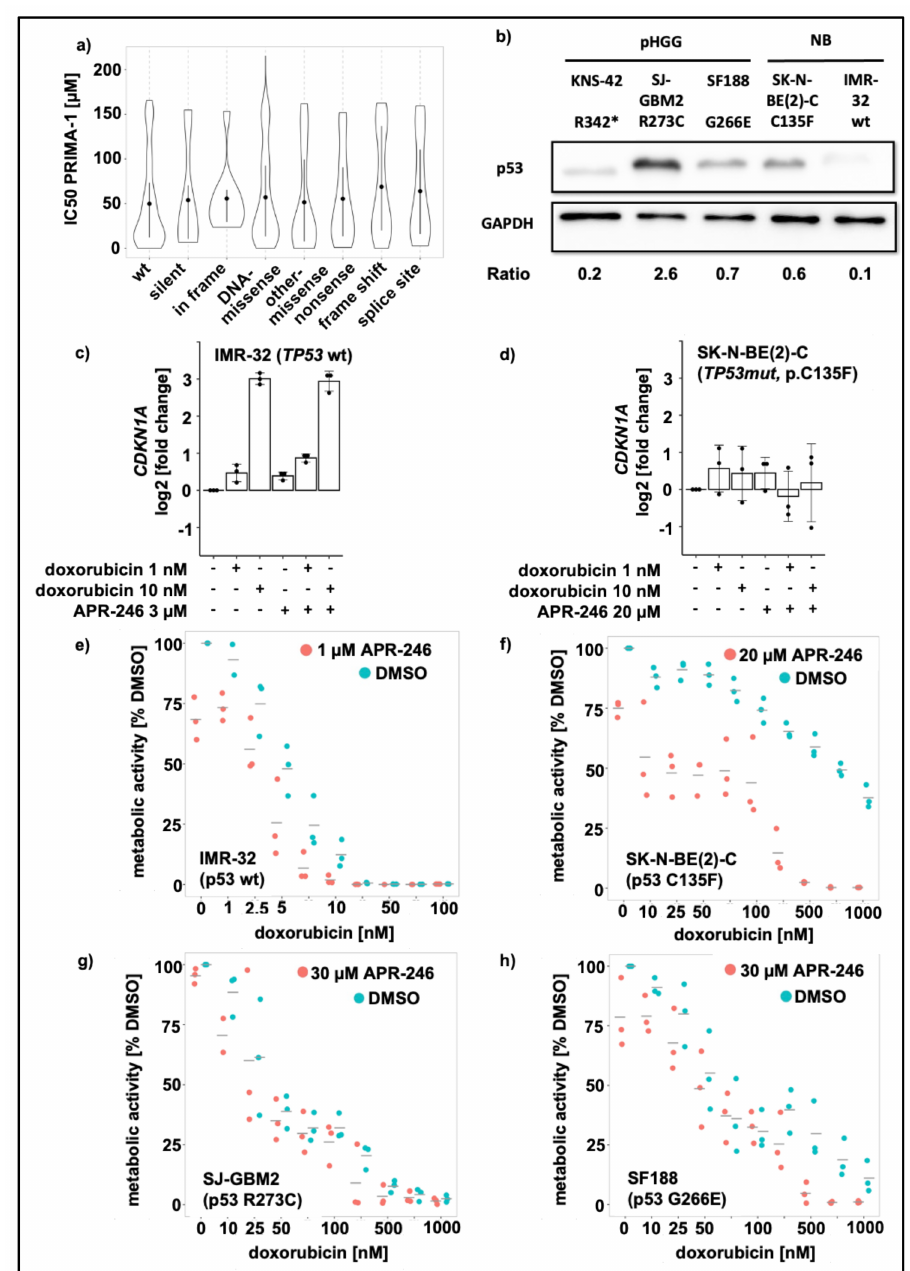
Figure 1. TP53 mutation status insufficiently predicts the APR-246/PRIMA-1 response. ( a ): PRIMA-1 sensitivity separated according to TP53 mutation status derived from Cancer Cell Line Encyclopedia and CTD 2 portal ( n = 805); ( b ): Expression of p53 is shown in the Western blot of the whole cell lysates of one TP53 nonsense mutated cell line (KNS-42), three TP53 missense mutated cell lines (SJ-GBM2, SF188, SK-N-BE(2)-C) and one TP53 wild type cell line (IMR-32). GAPDH served as loading control. The ratio indicates normalization of p53 to the GAPDH signal; ( c , d ): RT-PCR measurement of TP53 pathway activation. CDKN1A expression is depicted as log2 transformed fold change to solvent control. Treatment was applied for 24 h with doxorubicin or APR-246, alone or in combination, as indicated; ( e , f ): metabolic activity measurement with CellTiter Glo-assay in neuroblastoma cell lines IMR-32 ( e ) and SK-N-BE(2)-C ( f ) after 72 h treatment. IMR-32 ( e ) were treated with 0–100